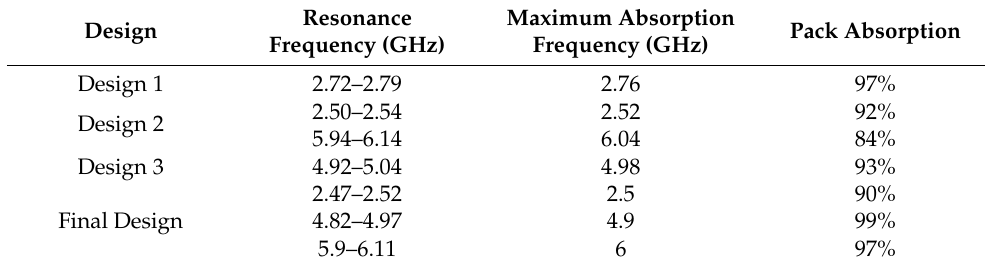
Figure 3. ( a ) Design evaluation of projected MMA, ( b ) absorption plot of design evaluation. Table 2. Peaks and maximum absorption of different designs.